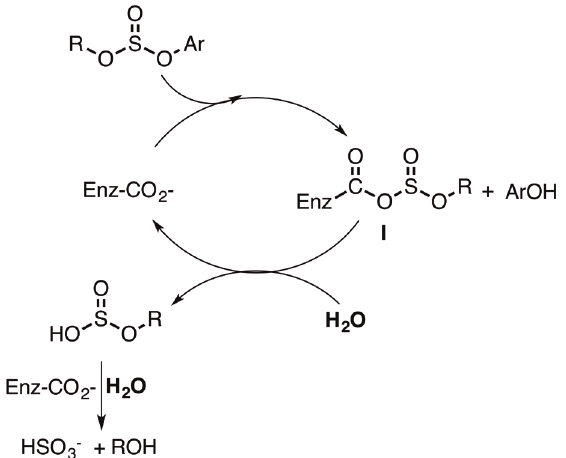
Figure 33 - Pathway for the pepsin-catalyzed hydrolysis of sulfite esters described by Stein and Fahrn